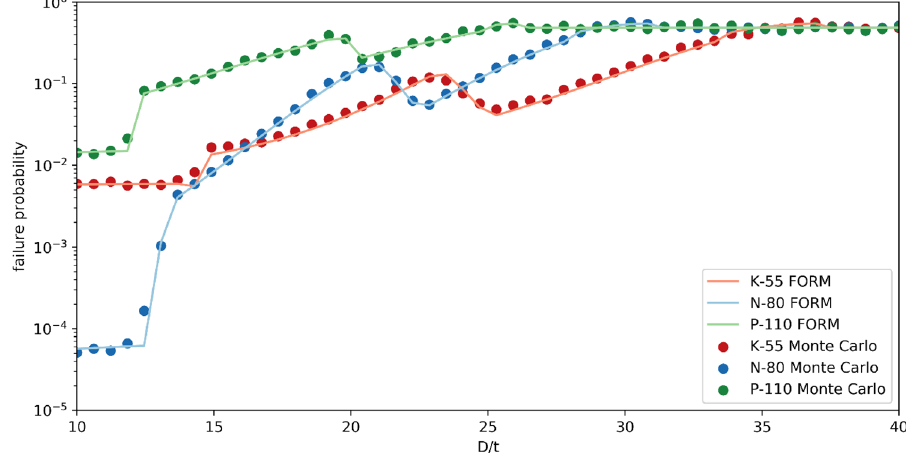
Fig. 4 Collapse failure prob- abilities over D/t